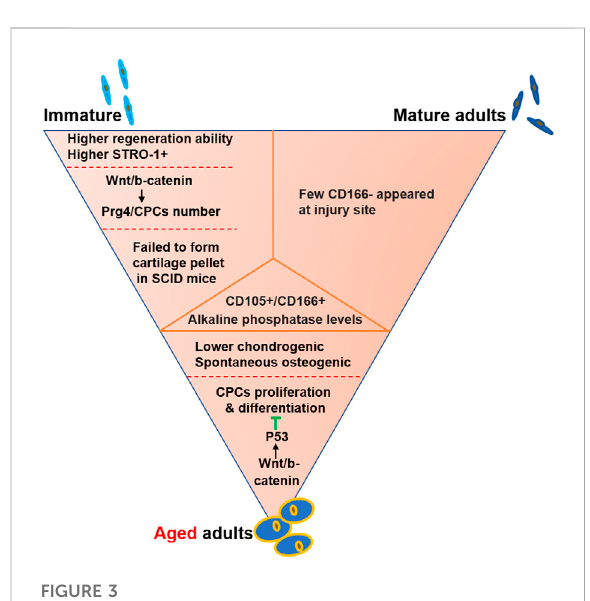
FIGURE 3 CPCs in immature, mature and elder cartilage. The common properties were listed in the middle orange triangle. Meanwhile, the main differences were showed near the sketch cells, including immature, mature and aged